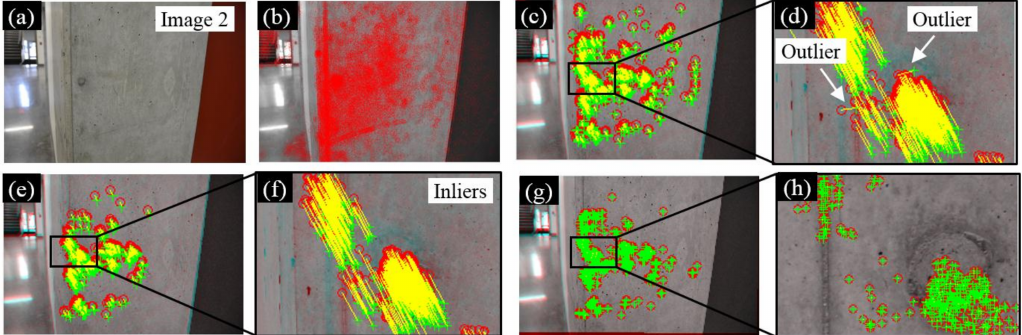
Figure 3. Demonstration of feature matching. ( a ) Second input image of the concrete column; ( b ) Shi–Tomasi features in Image 2; ( c ) matched feature points between Image 1 and 2; ( d ) a detailed look of Figure 3c; ( e ) inliers for estimating the transformation matrix; ( f ) a detailed look of Figure 3e; ( g ) inliers after image mapping; and ( h ) a detailed look of Figure 3g. Red circles in Figure 3c–h are features in Image 1, while green crosses are features in Image